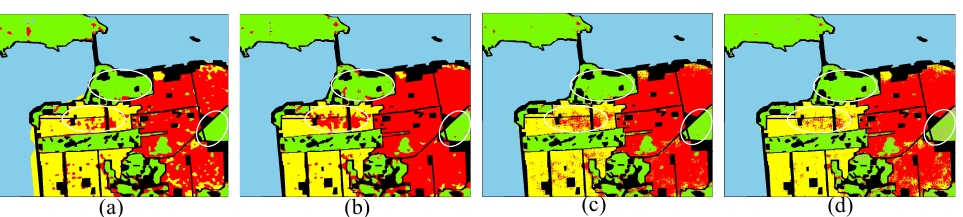
Figure 23. Classification maps of AIRSAR San Francisco dataset with different classification methods.